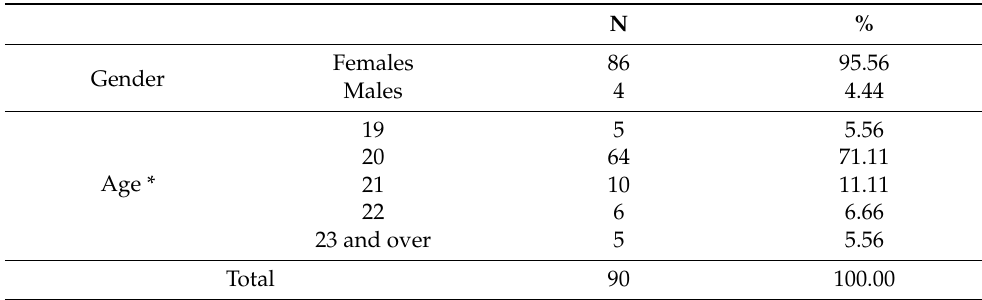
Table 2. Demographic characteristics of the examined group of students who participated in the 3-year study